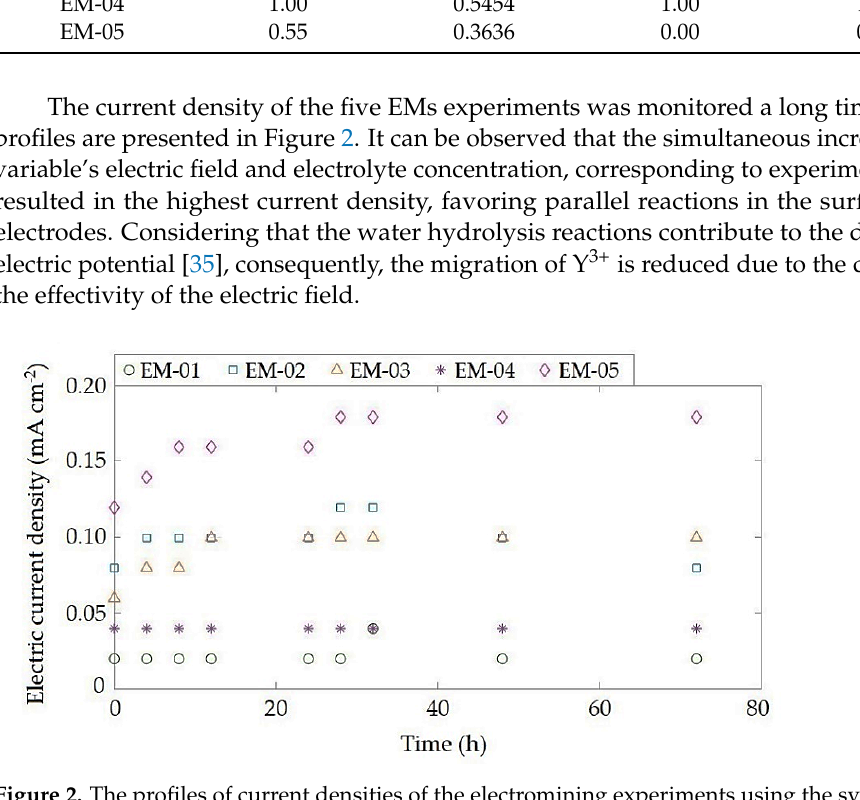
Figure 2. The profiles of current densities of the electromining experiments using the synthetic